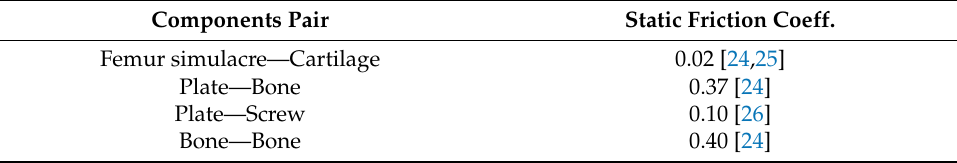
Table 4. Static friction coefficients considered for each components